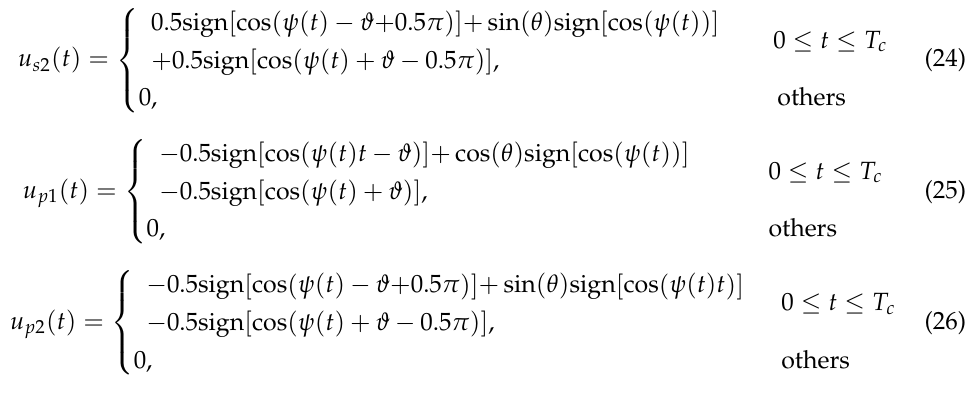
Figure 3. Direct generation with composed subcarriers.